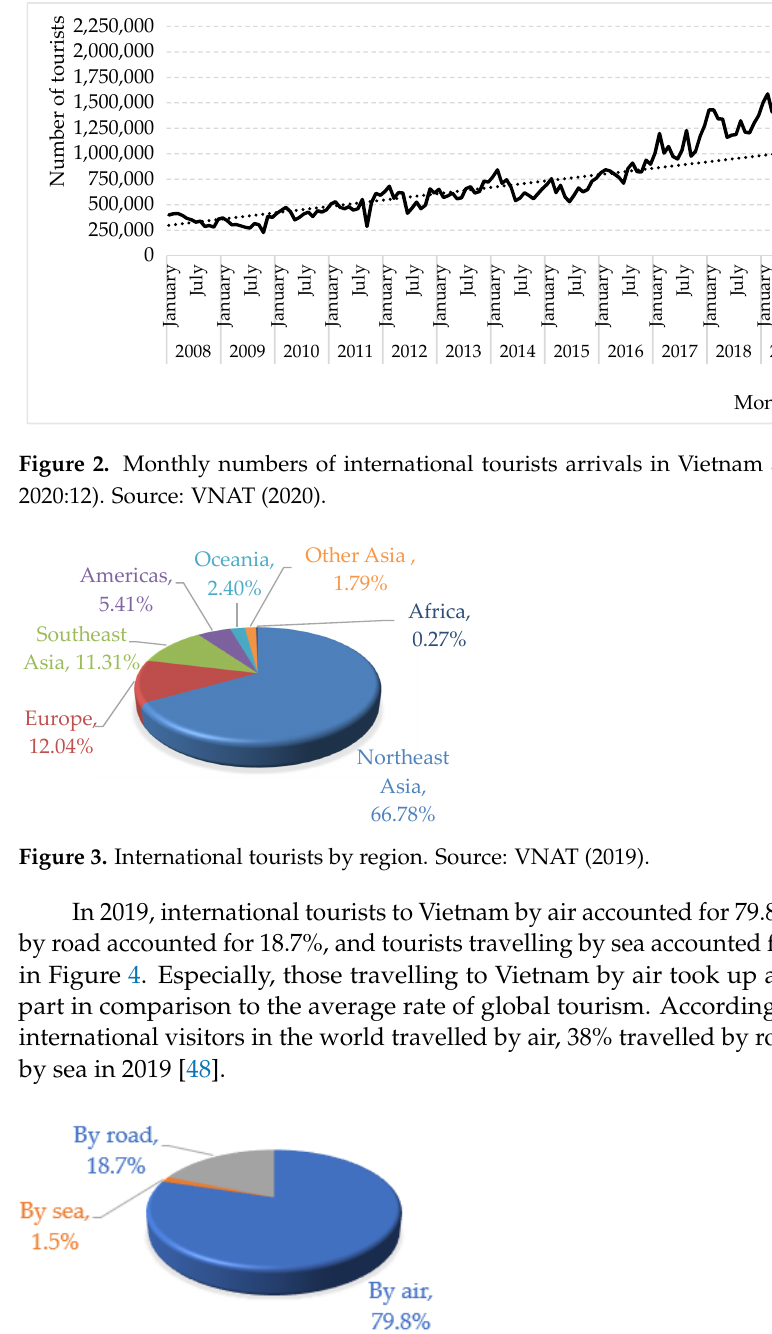
Figure 4. International tourists by mode of transport. Source: VNAT (2019).